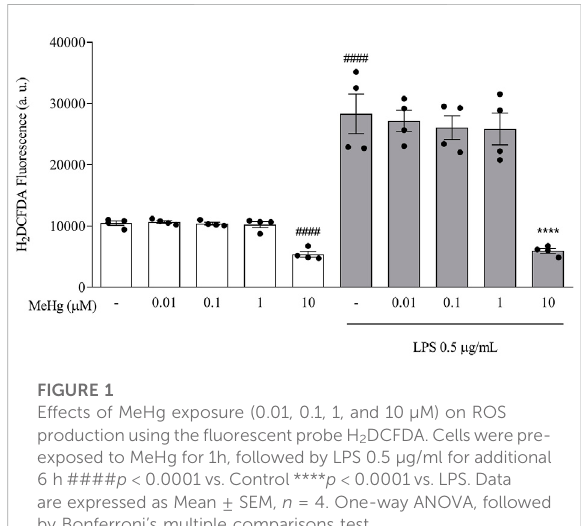
FIGURE 1 Effects of MeHg exposure (0.01, 0.1, 1, and 10 µM) on ROS productionusingthe fl uorescentprobeH 2 DCFDA.Cellswerepre- exposed to MeHg for 1h, followed by LPS 0.5 μ g/ml for additional 6 h #### p < 0.0001 vs. Control **** p < 0.0001 vs. LPS. Data are expressed as Mean ± SEM, n = 4. One-way ANOVA, followed by Bonferroni ’ s multiple comparisons